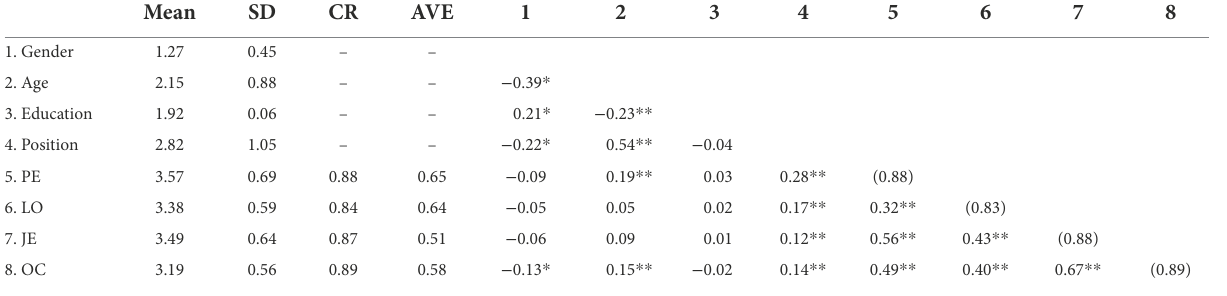
TABLE 2 Correlations and descriptive statistics ( N =